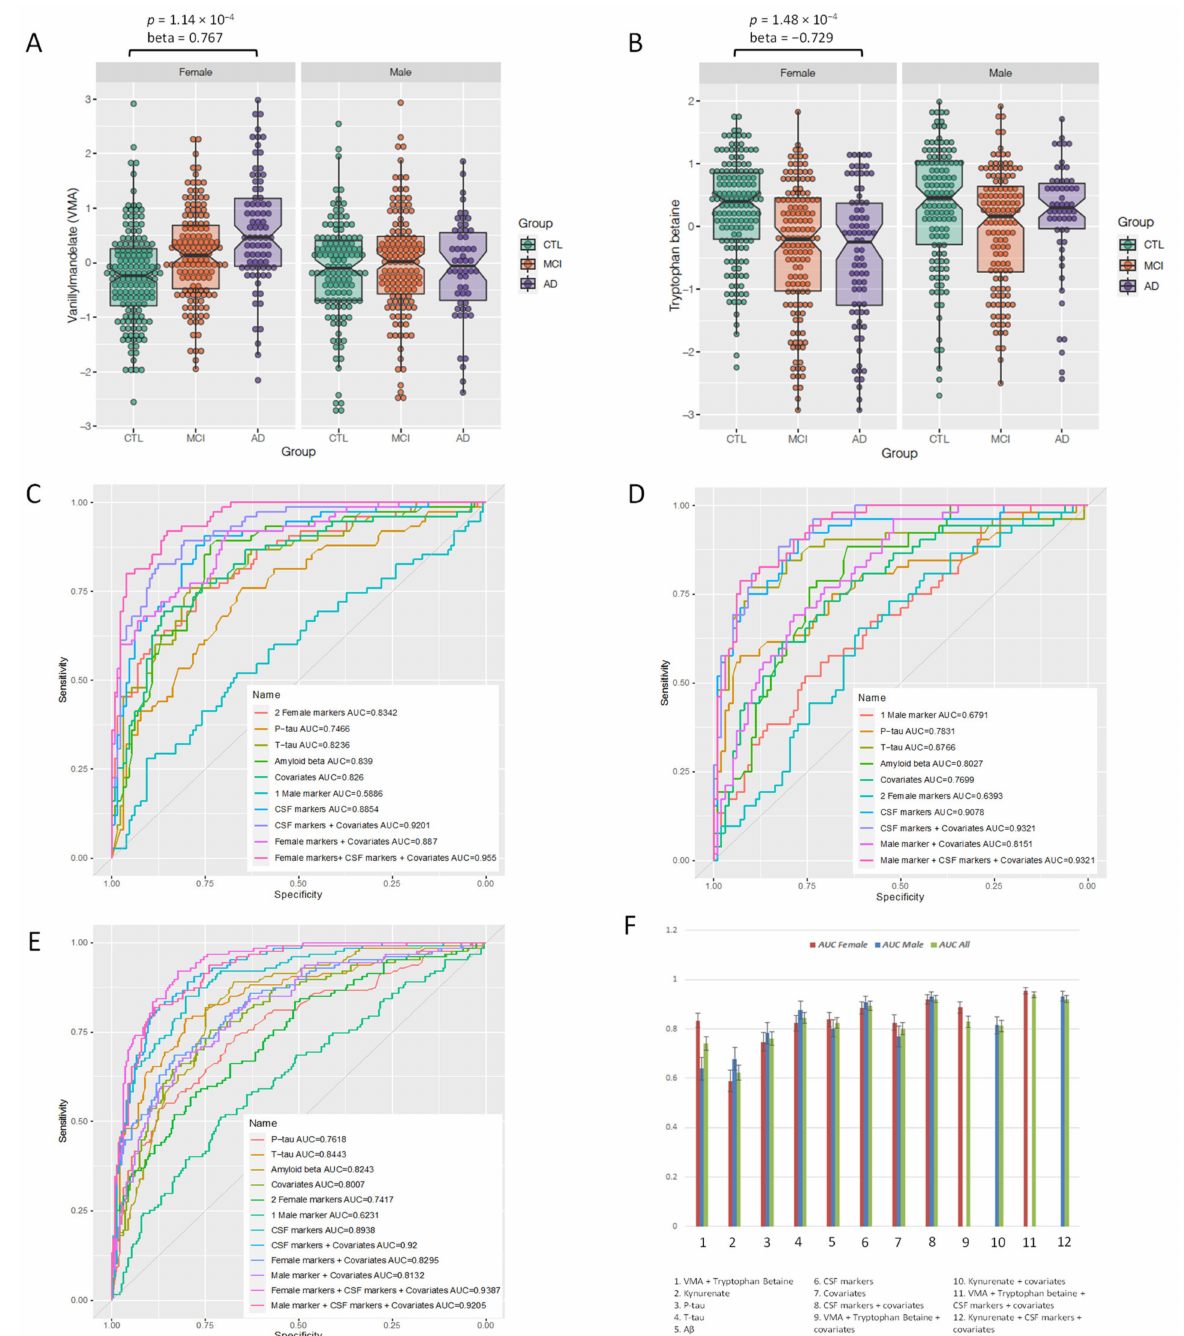
Figure 1. Box plots of two female biomarkers ( A ) vanillylmandelate and ( B ) tryptophan betaine, the p value (below Bonferroni significance threshold) and the association coefficient (beta) for metabolites in relation to diagnosis (AD/CTL) are shown above the box plots; ROC graphs, comparing area under curve (AUC) in predictive models using sex-specific biomarkers, CSF biomarkers, covariates, and the combination of them in ( C ) the female sub-dataset; ( D ) the male sub-dataset; ( E ) the full cohort; ( F ) Bar plot summarises the AUC of the above mentioned ROC curves together with standard errors after